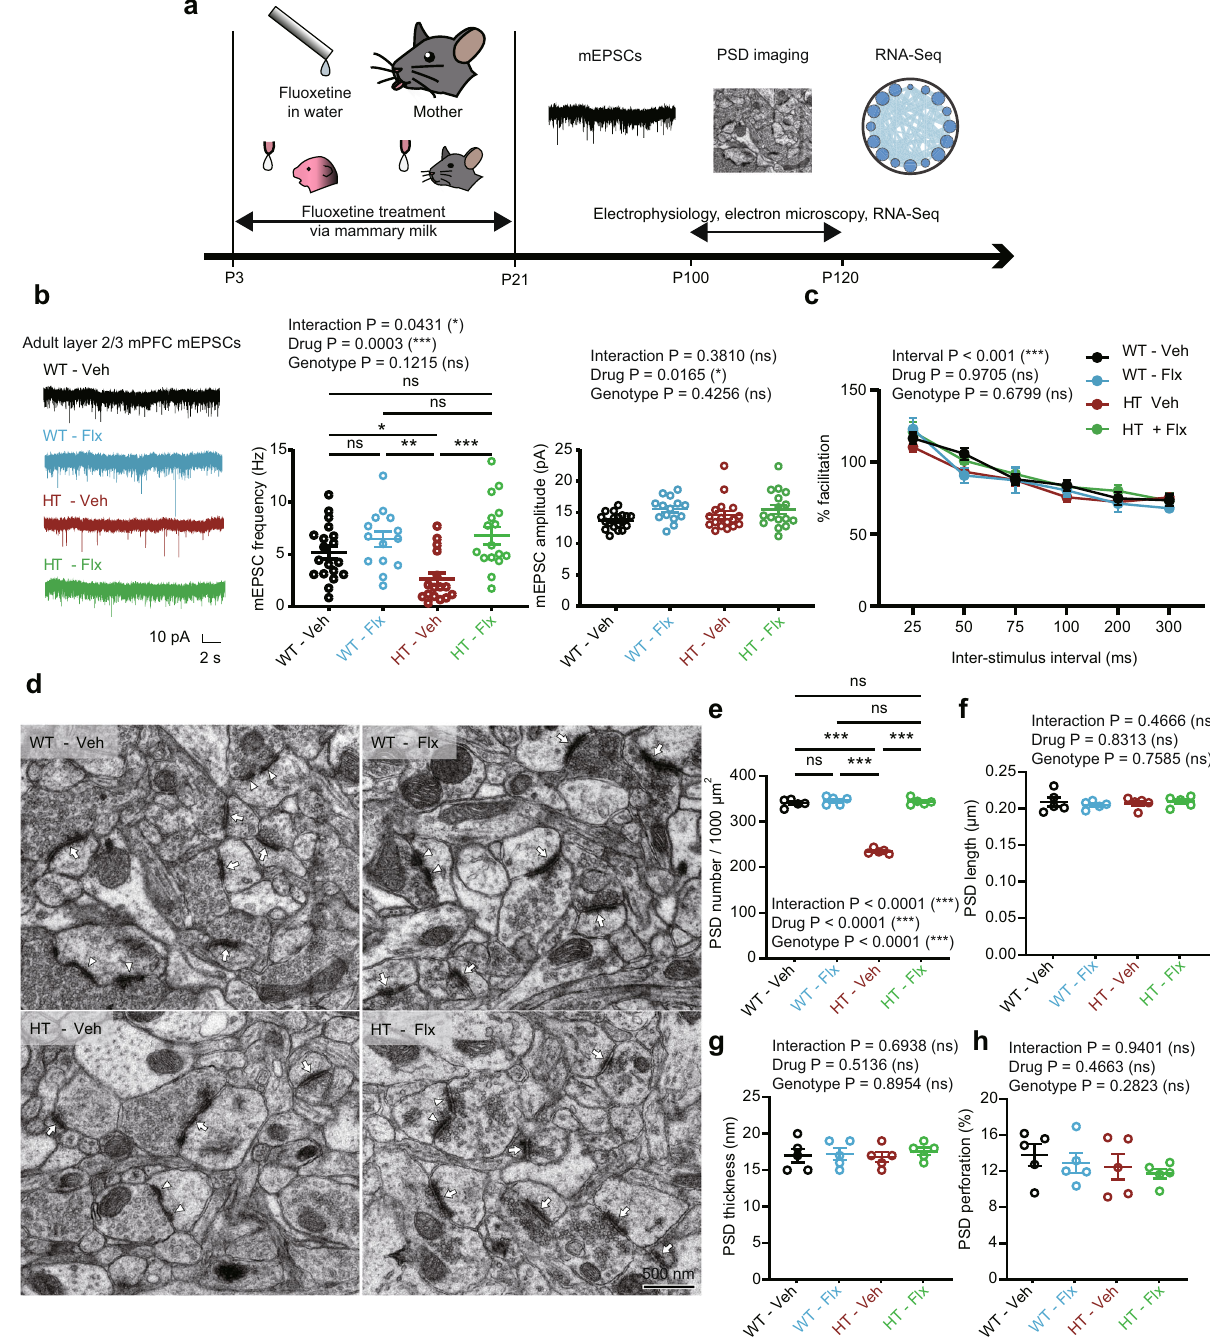
Fig.5|Early,chronic fl uoxetinetreatmentpreventsexcitatorysynapticde fi cits appearing in adult Arid1b +/ – mice. a Schematic diagram showing early, chronic fl uoxetine treatment (P3 – 21) through mother ’ s milk and prevention of excitatory synaptic de fi cits at P100, as determined by measuring mEPSCs. b Early, chronic fl uoxetine prevents the decrease in mEPSC frequency in layer 2/3 pyramidal neu- rons in the prelimbic region of the mPFC of adult Arid1b +/ – mice without affecting mEPSCfrequencyinWTmice.( n =19neuronsfrom4mice[WT-Veh],14,3[WT-Flx], 16, 3 [HT-Veh], and 16, 3 [HT-Flx], two-way ANOVA with Tukey ’ s test, [frequency, WT-Veh vs HT-Veh: p =0.0462, WT-Veh vs WT-Flx: p =0.5802, WT-Veh vs HT-Flx: p =0.3373, HT-Veh vs WT-Flx: p =0.0025, HT-Veh vs HT-Flx: p =0.0005, WT-Flx vs HT-Flx: p =0.9866]). c Early, chronic fl uoxetine does not affect paired-pulse facil- itation in layer 2/3 pyramidal neurons in the prelimbic region of the mPFC of